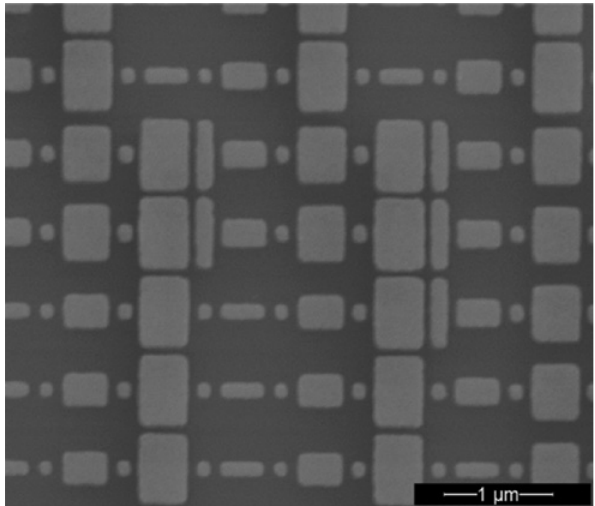
Figure 14: Image of an array of coupled patch-dipole nanoantennas. Reprinted (adapted) with permission from Ref. [56]. Copyright 2014 American Chemical